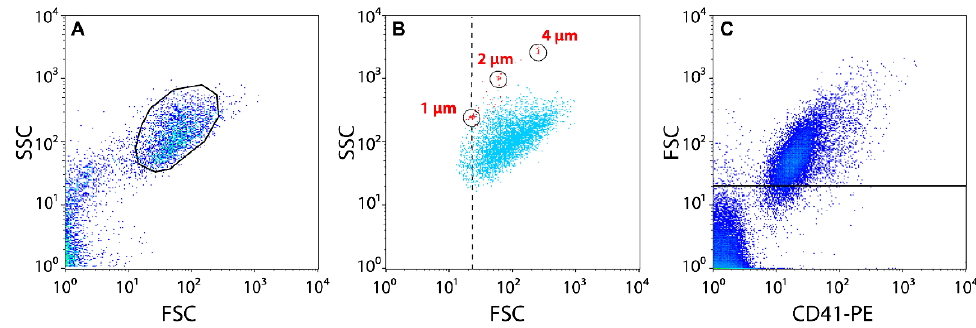
Figure 6. Flow cytometry of isolated platelets. ( A ) Platelets were gated (black circle) based on the size and granularity using Forward Light Scatter (FSC) and Side Scatter (SSC) channels. ( B ) The lower size limit of the platelet gate in FSC/SSC dot-plots (dashed line) was established using 1-, 2-, and 4-µm latex beads. ( C ) In addition to the FSC/SSC scatter, platelets were gated (above the line) using anti-CD41-PE-labeled Abs.